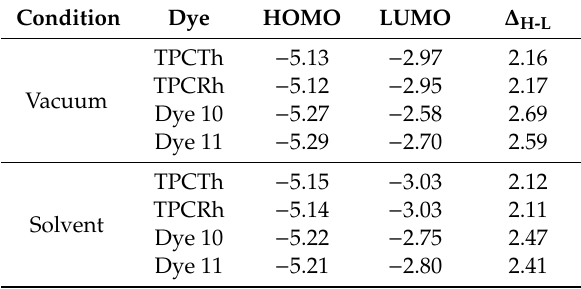
Table 2. Energy levels and energy gaps of four molecules in vacuum and solvent (eV). Condition